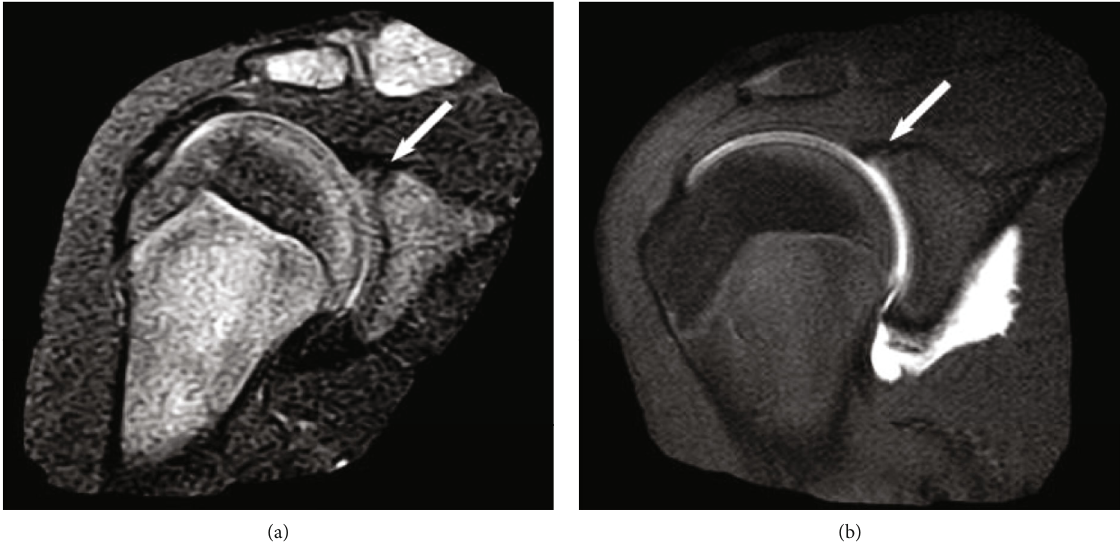
Figure 2: MR images of the patient ’ s injured shoulder. Arrows point to the suspected SLAP tear in both images. (a) This image was taken approximately 11 weeks after the index injury. (b) This image is from the second MRI, which was approximately 27 weeks after the index injury. Because T2-weighted imaging was not performed during the second MRI scan, a direct comparison cannot be made to part (a). Also, the left (noninjured) shoulder was not evaluated with